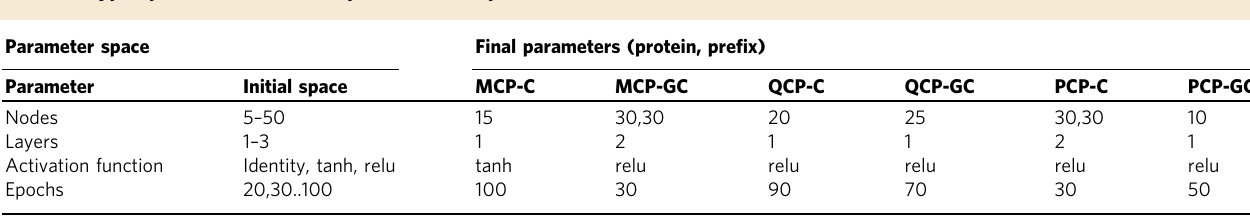
(Left) The search space of the hyper-parameters search. (Right) The hyper-parameters of the fi nal models. NATURE COMMUNICATIONS| (2021) 12:1576